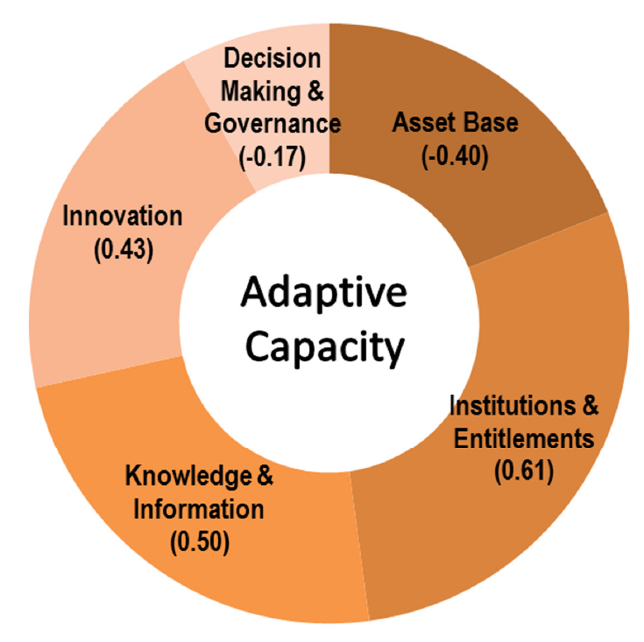
Figure4. Relativeweights(contributions)ofthemajorcomponents. Sources: